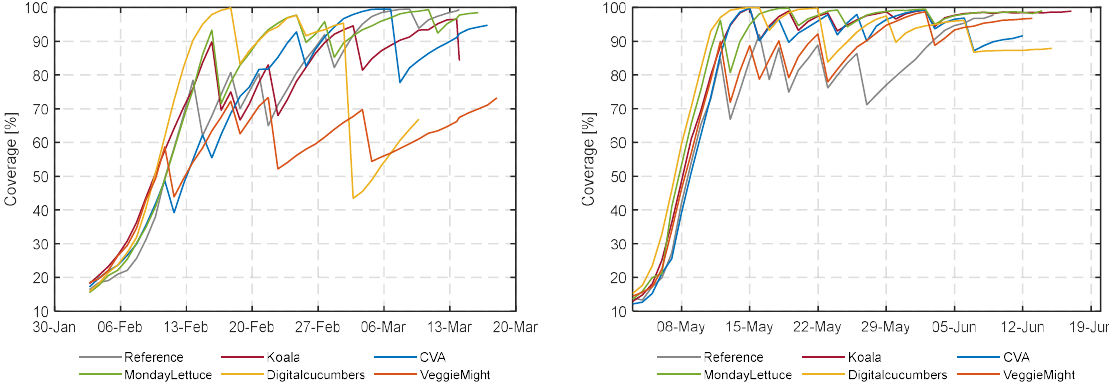
Figure 14. Coverage [%] of the greenhouse with lettuce heads, as calculated with the segmentation algorithm The frequently shown stepwise fall of coverage is a result of spacing actions.